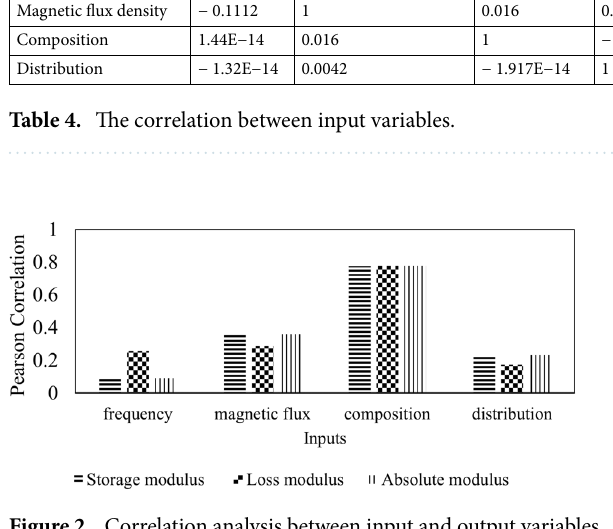
Figure 2. Correlation analysis between input and output